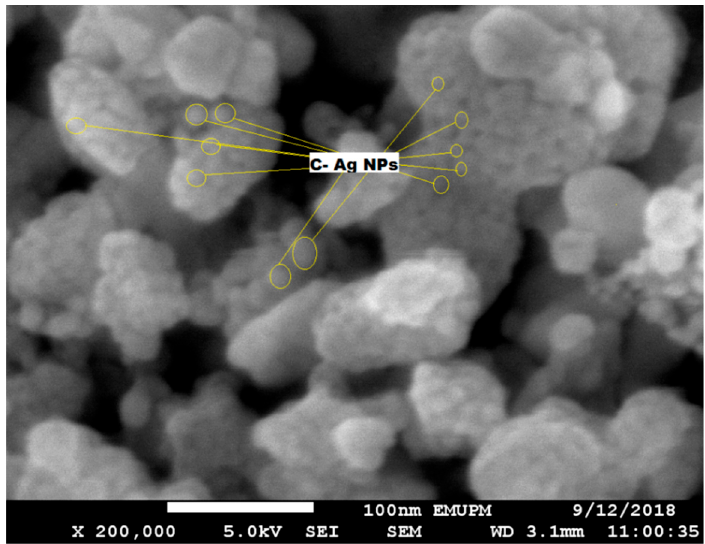
Figure 6. SEM micrographs of C-Ag NPs at 200,000× with prominent spherical NPs in the clusters.